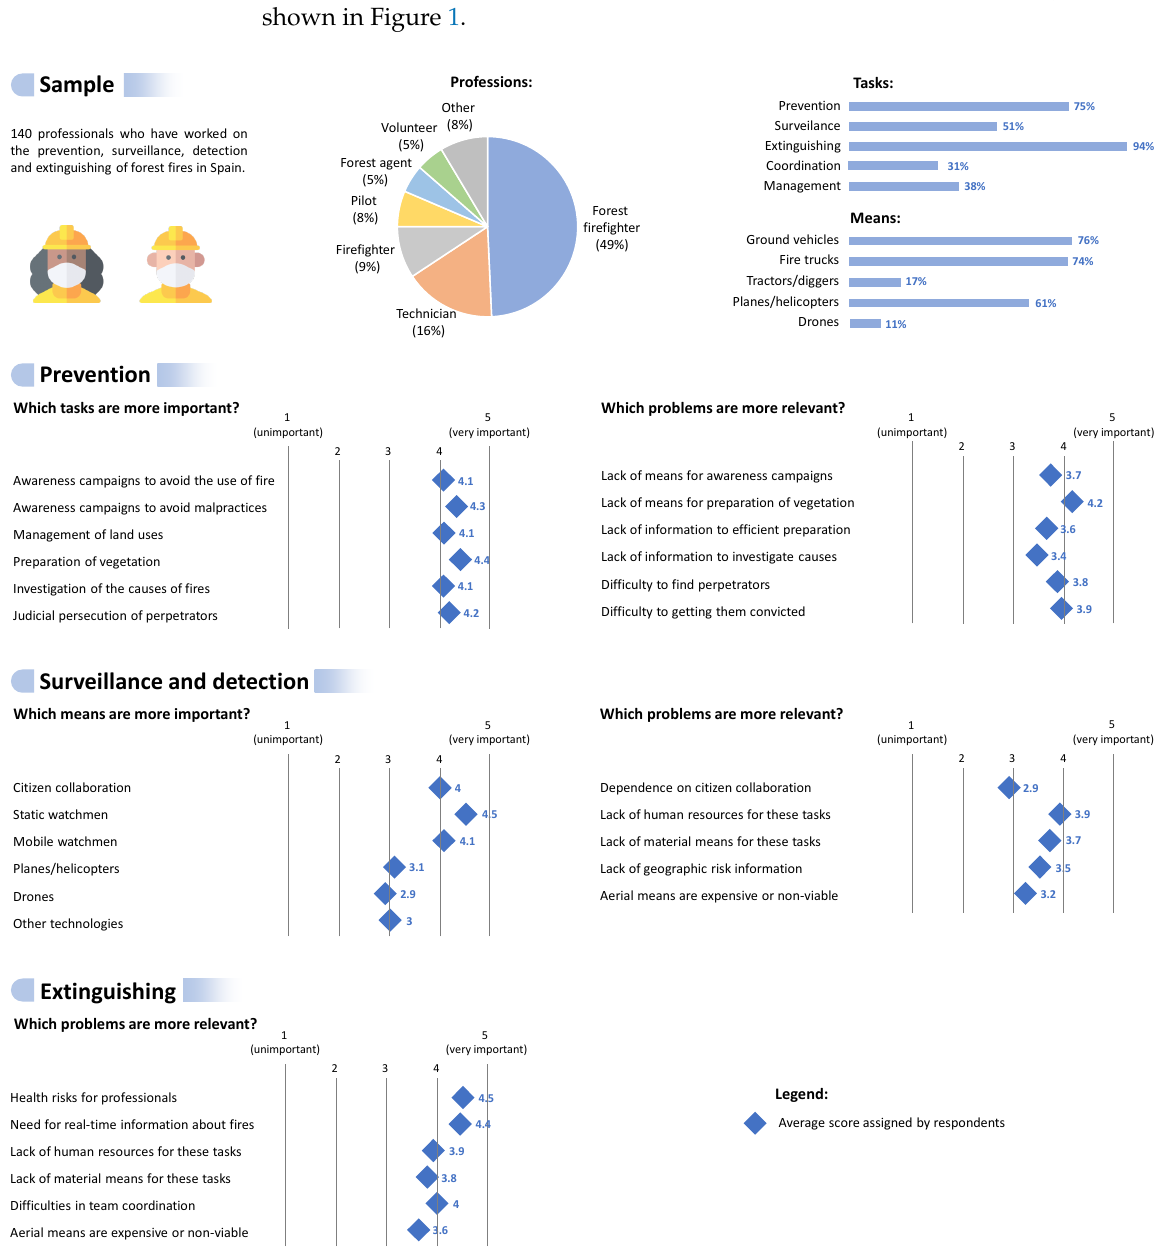
Figure 1. Results of the problem survey about forest fires in